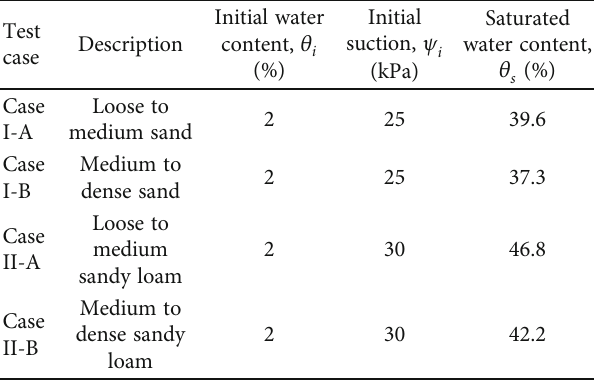
Table 3: Soil parameters adopted for unsaturated fl ow